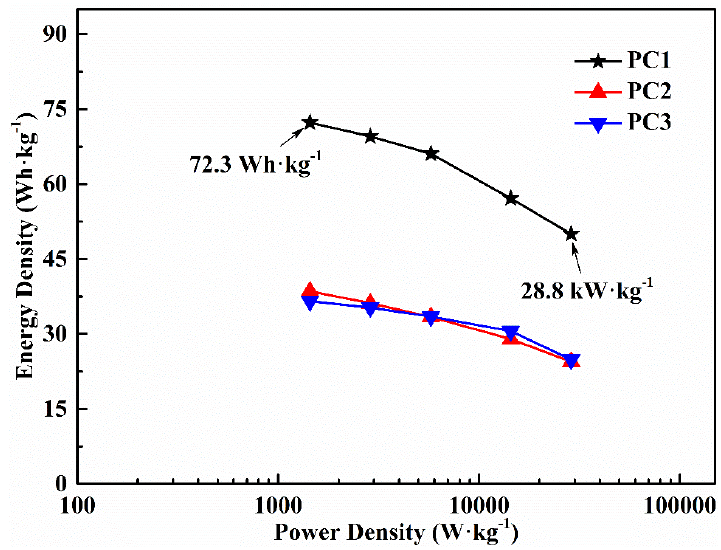
Figure 7. Ragone plot of porous carbons (PCs)-based symmetric supercapacitors.